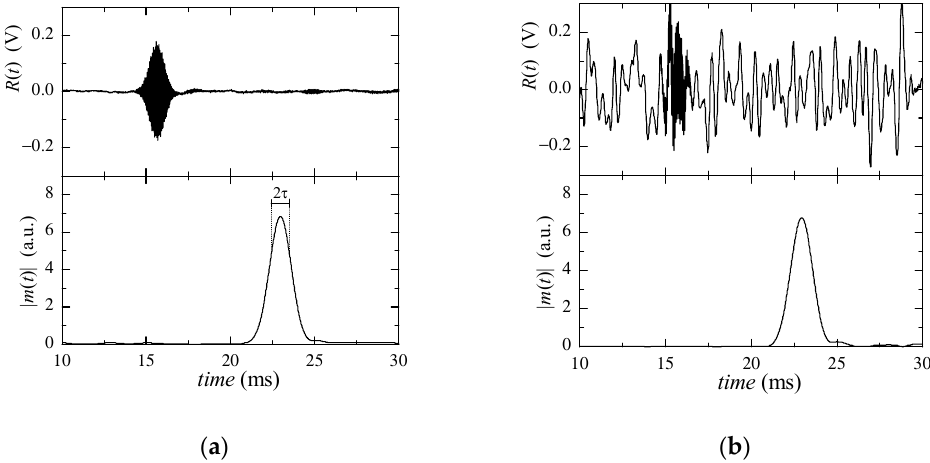
Figure 4. Plots of the signal received by the microphone (top) and of the output of the correlator in a silent environment ( a ). Signal received by the microphone (top) and output of the correlator in a noisy environment ( b ). Measurements reported in ( b ) were obtained with the ambient noise level such that the peak-to-peak signal captured by the microphone was at the same level of the received pulse when no pulse was present.